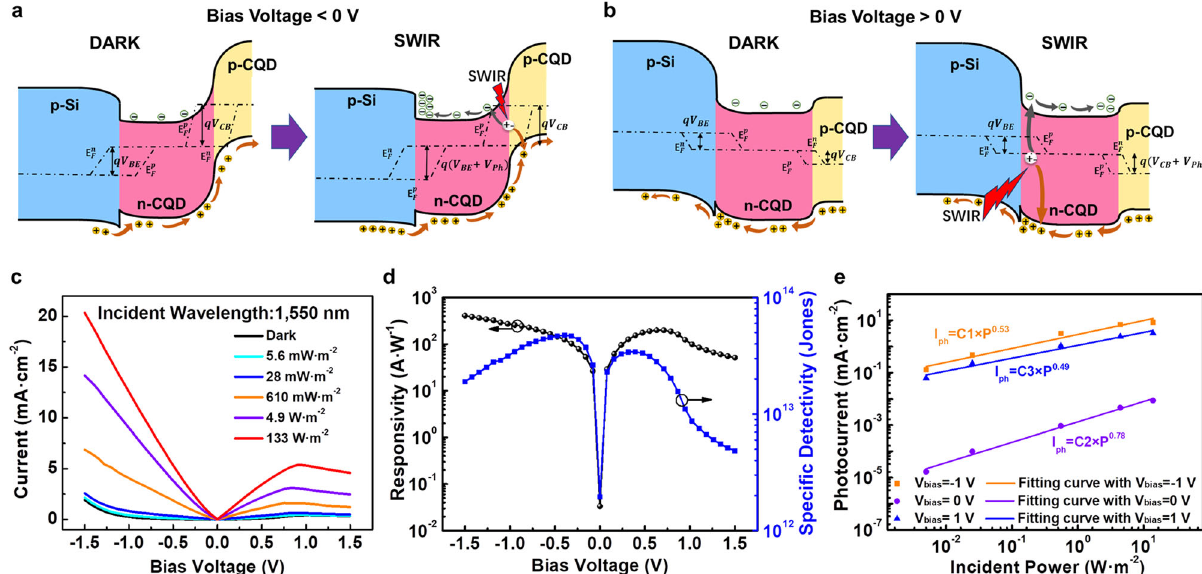
Fig. 3 Operation of the PVTRI with excitation of SWIR. Energy bands and operation mechanism of the PVTRI with a negative bias ( V bias < 0 V) and b positive bias ( V bias > 0 V) voltages with excitation of SWIR and in the dark, respectively. c Output characteristics of the PVTRI under 1550 nm illumination with different incident powers. d The responsivity and speci fi c detectivity of the PVTRI as a function of bias voltages at low incident power of 5.6 mW·m − 2 . e The photocurrents as functions of incident powers at 0, − 1, and 1 V, p-Si:n-CQD heterojunction. Under SWIR illumination, photo- induced carriers can only generate at the n-CQD side of the reversed heterojunction. The photoelectrons will be blocked off at the n-CQD:p-CQD junction and a negative photovoltage is produced at the interface, shrinks the depletion region of n- CQD:p-CQD junction, and extracts holes from p-CQD to the base region (n-CQD). However, only part of the holes can transport across the valence band offset induced barrier by